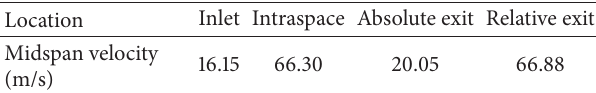
Table 1: Predicted midspan flow speeds and locations.